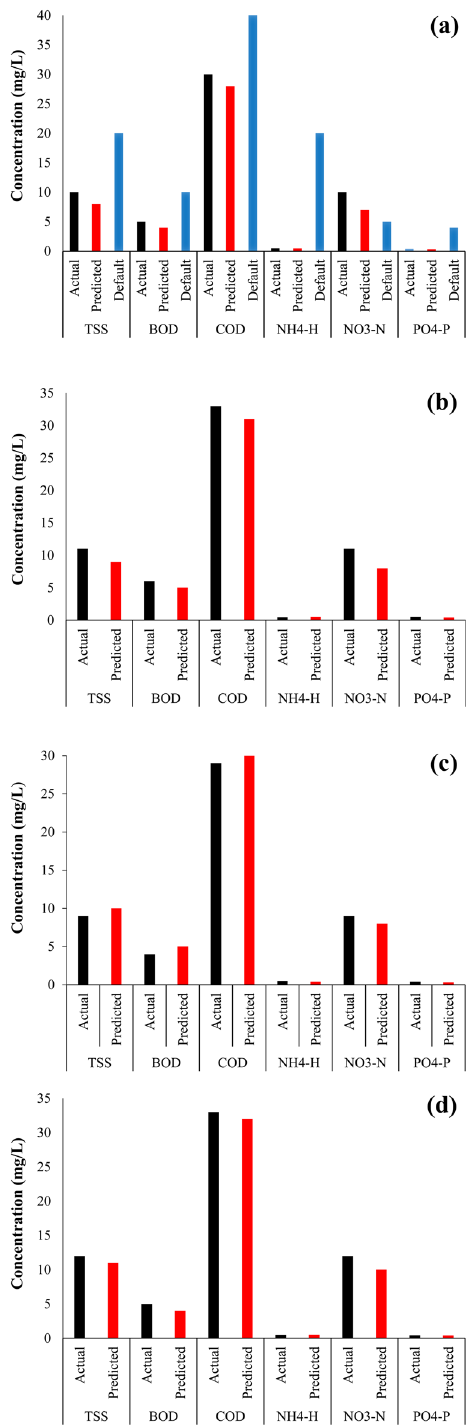
Figure 6. Simulated and actual data comparison: ( a ) uncalibrated and calibrated model (month 1), ( b ) validated (month 2), ( c ) validated (month 3), and ( d ) validated (month